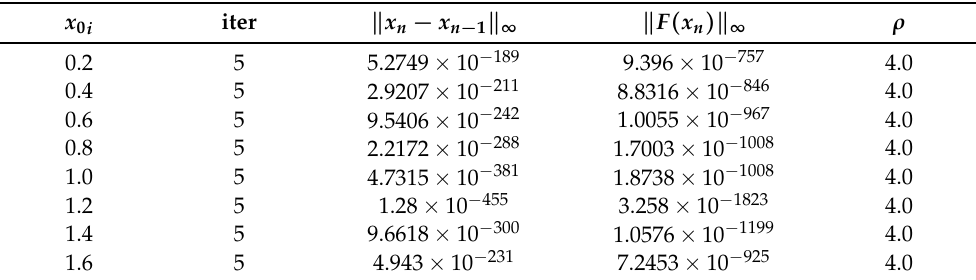
Table 3. Numerical results extension of Chun’s method with different initial estimations. x 0 i iter (cid:107) x n − x n − 1 (cid:107)